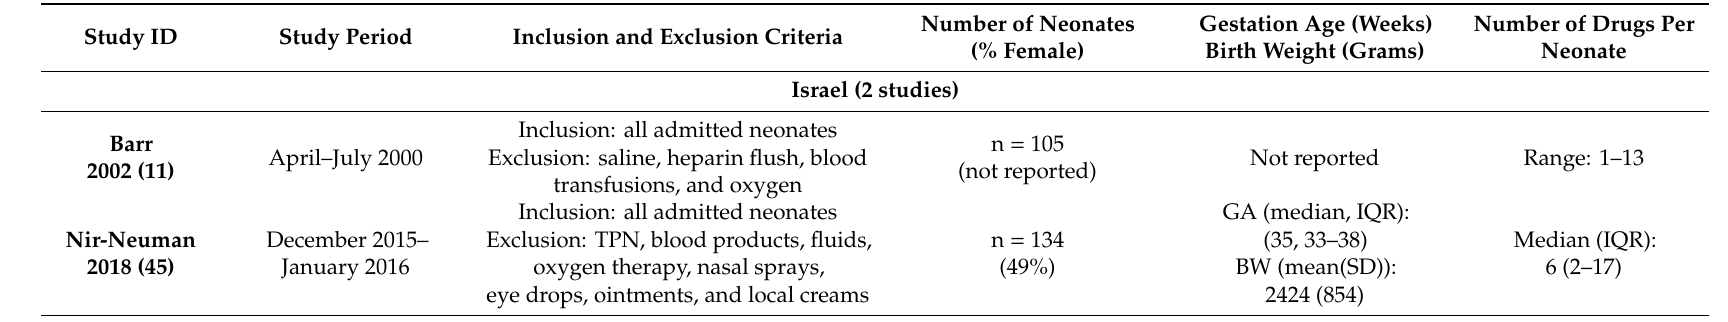
Table A3. Studies of drug utilization in Middle East (2